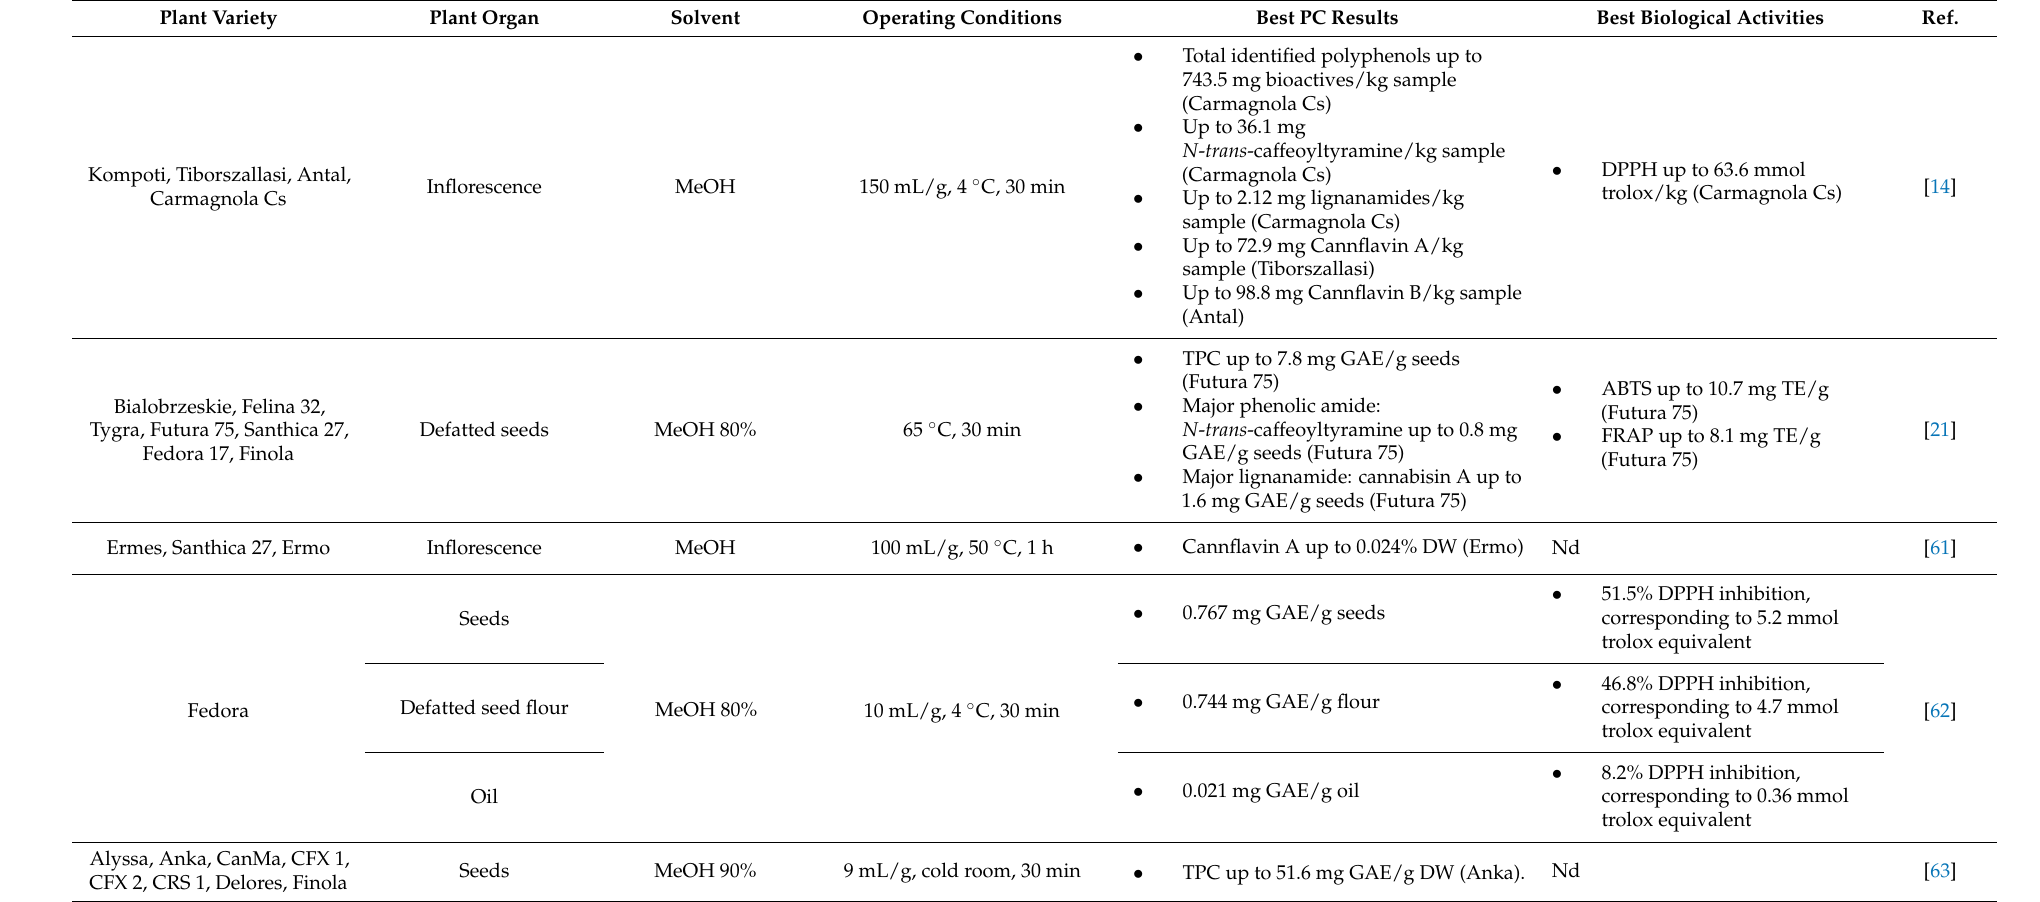
Table 2. Studies using ultrasound assisted extraction technique for the recovery of phenolic